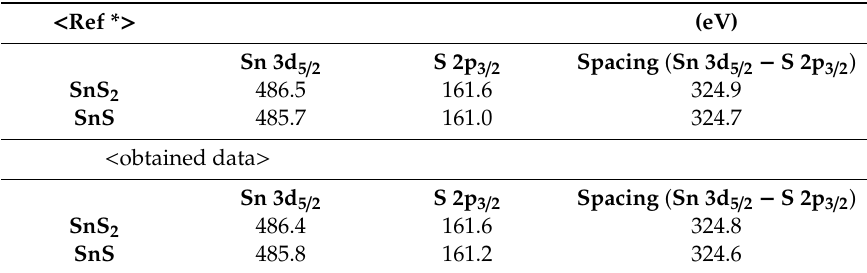
Table 1. Sn 3d and S 2p peaks of the XPS spectra in comparison with the reference.